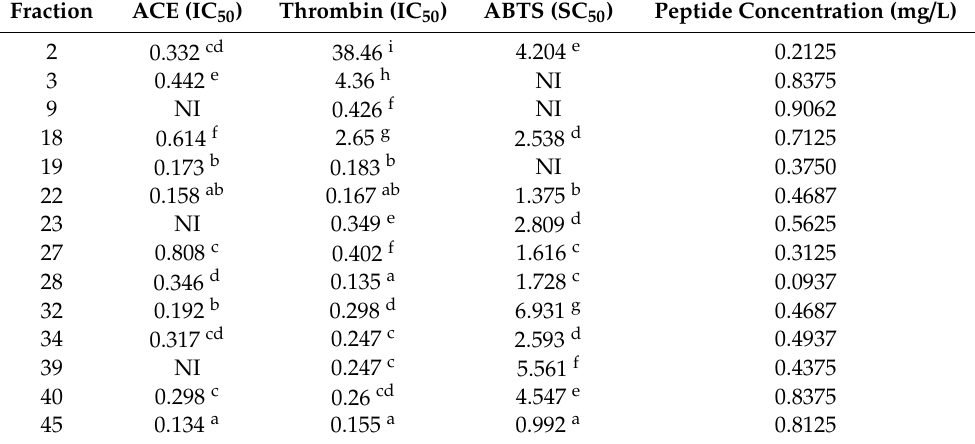
Table 2. Bioactivities of amaranth protein fractions (Angiotensin I-Converting Enzyme and